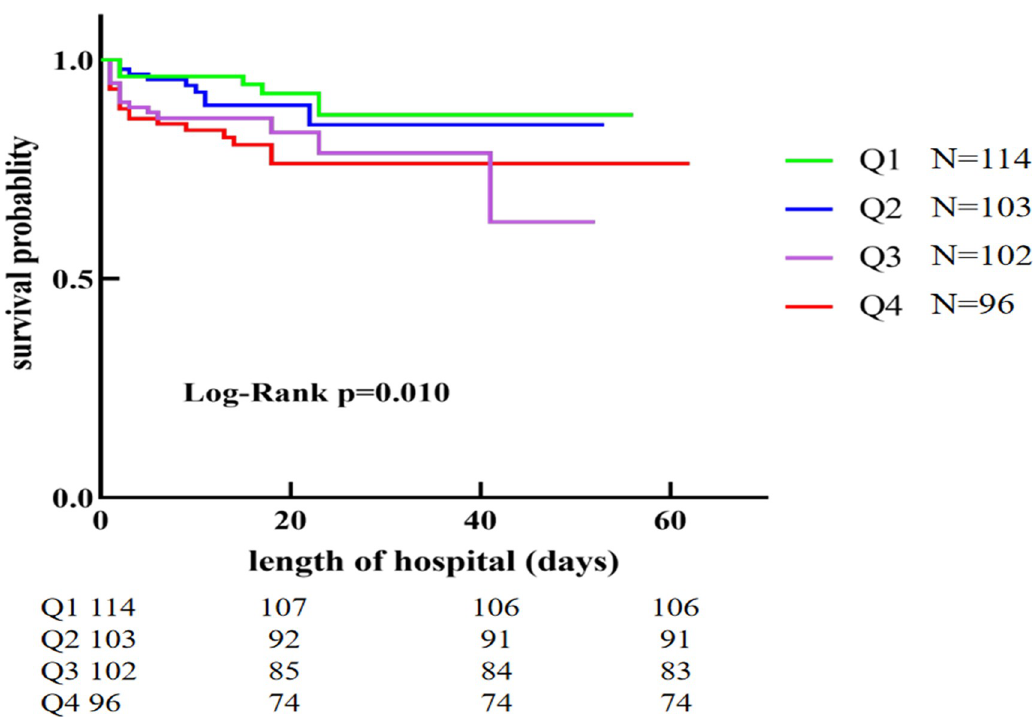
Fig 2. Kaplan-Meier curves for the chronological trend in mortality on serum sodium quartiles